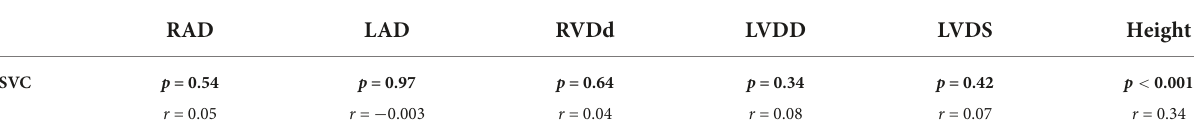
TABLE 3 Correlation analysis of LSVC.